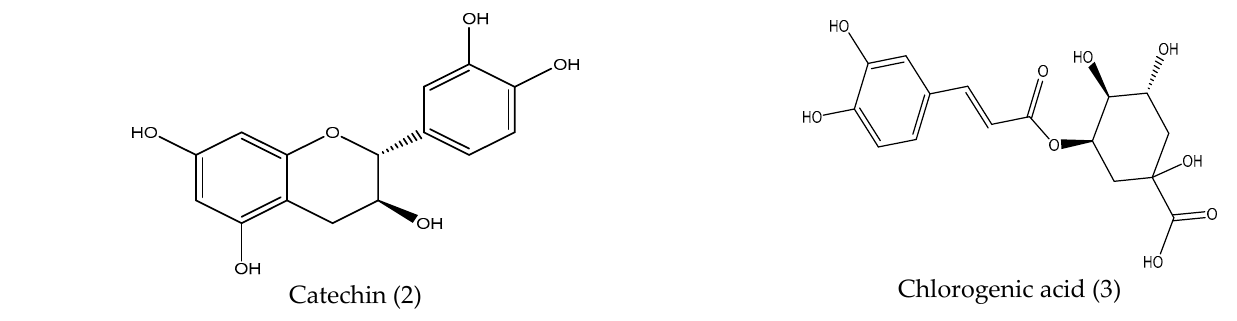
Figure 1. The chemical structure of catechin and chlorogenic acid.